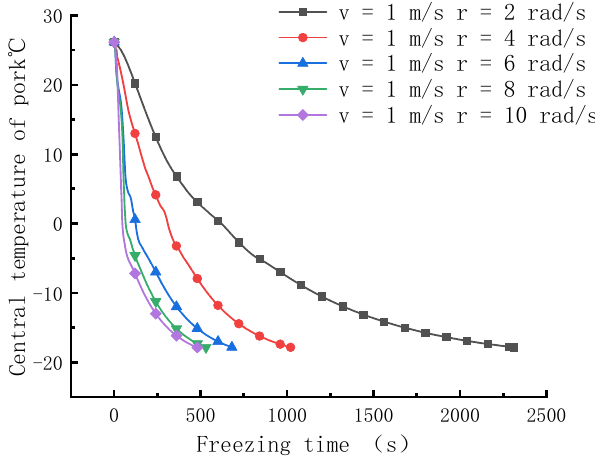
Figure 11. Histogram of load frame speed and freezing time. 4